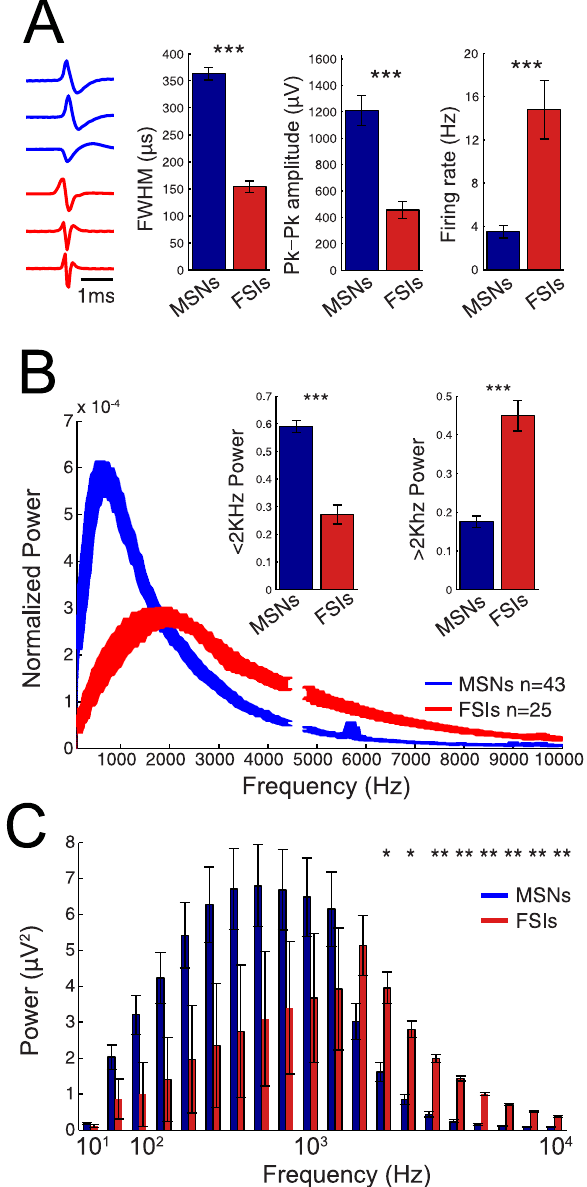
Fig 3. Neuronal cell types have specific high frequency signatures. A) Left : Example spike waveforms of MSNs and FSIs. Right : MSNs exhibit wider width, higher amplitude, and lower firing rates. B) Mean power spectrum of MSN and FSIs. Mesh represents standard error. Each spike is normalized by the area under the curve prior to averaging. Insert : Comparison of power above and below 2KHz. C) Total power contribution from well-isolated spikes in a given frequency band. Analysis takes into consideration power in each frequency band due to a single spike as well as the firing rate of that cell. Error bars denote SE. Time scale = 1ms. *** p < .001 , ** p < .01 , * p < .05